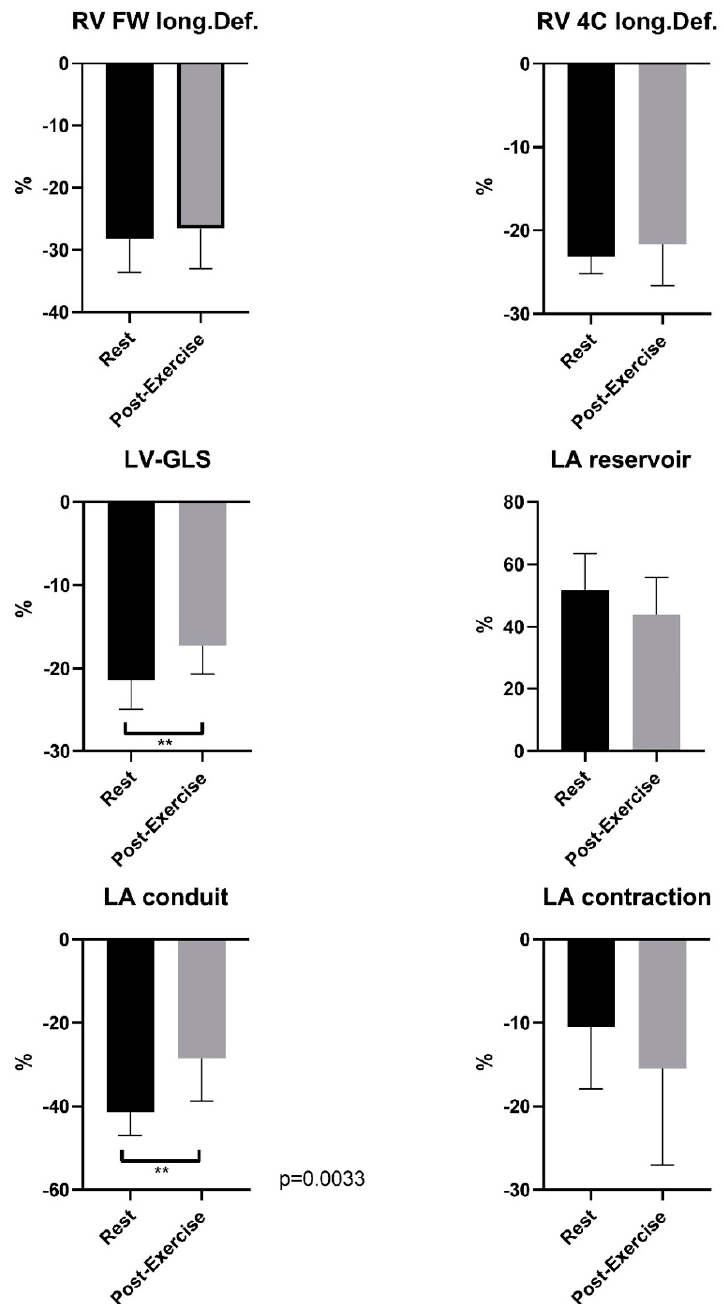
Figure 1. Speckle tracking analyses of world elite Ski-Mo professional–Comparison of mean LV- GLS, phasic LA strain and RV strain with significant differences between resting conditions and post-exercise. ** indicates p < 0.01.